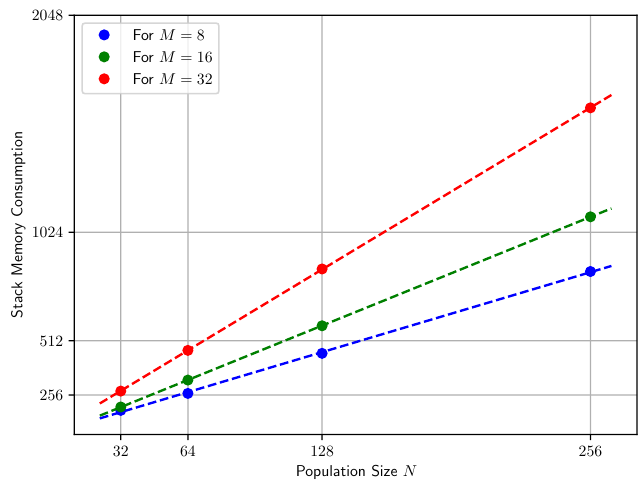
Figure 10. Stack memory consumption in master node.